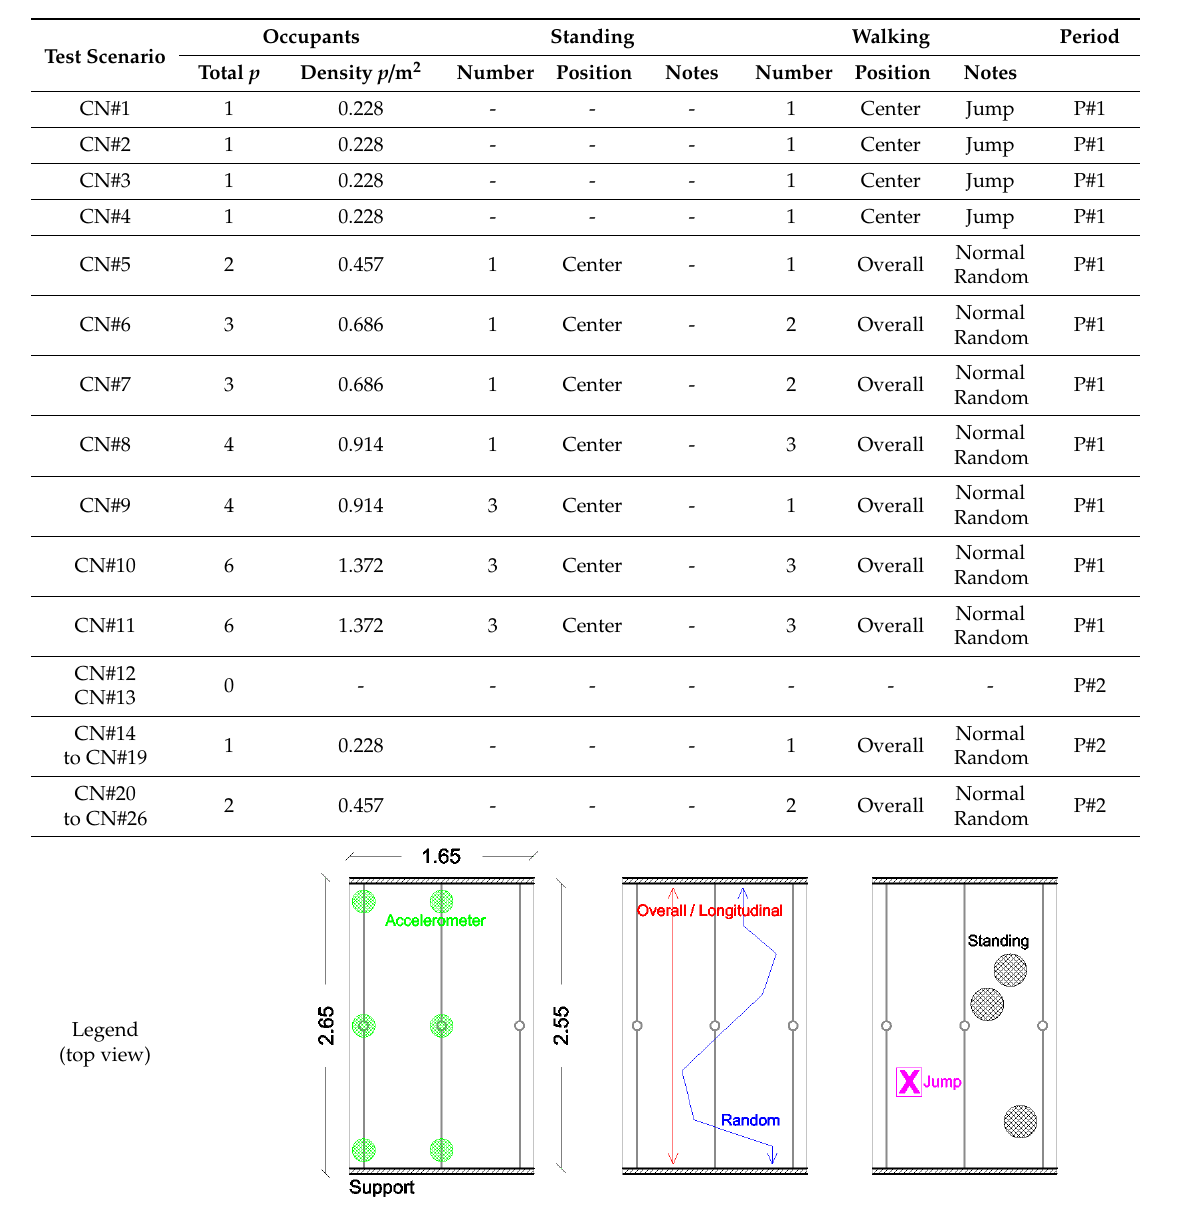
Table 2. Examined test scenarios for the system object of analysis (Figure